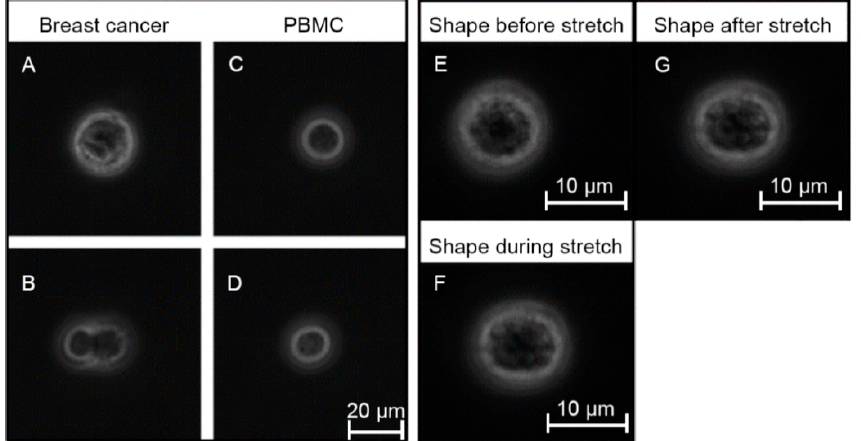
Figure 4. Representative phase contrast images obtained during mechanical probing using the optical stretcher. ( A ) Possible CTC candidate and ( B ) cell cluster—both detected in the CD45 depleted cell suspension from a breast cancer patient. ( C , D ) show PBMC after density gradient centrifugation, ( E – G ) show the shape of a breast cancer derived CTC candidate with particularly low mechanical resistance before, during and after optical stretching demonstrating that mechanical changes are very small.